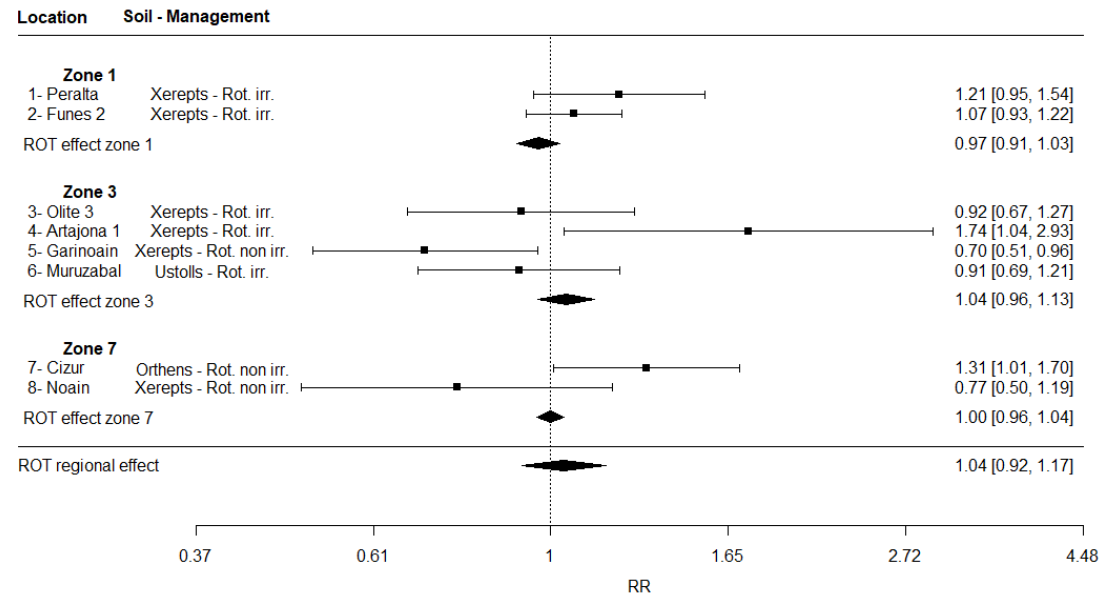
Figure 12. Response ratio (RR) of AWHC (0–30 cm) for the adaptive management strategy of crop rotations (ROT). Zones correspond to those in Figure 1. The effect was considered significant when the 95% confidence interval (CI) of the RR did not overlap one ( α = 0.05). Soil and management column includes information about principal soil group and irrigation regime in each group.